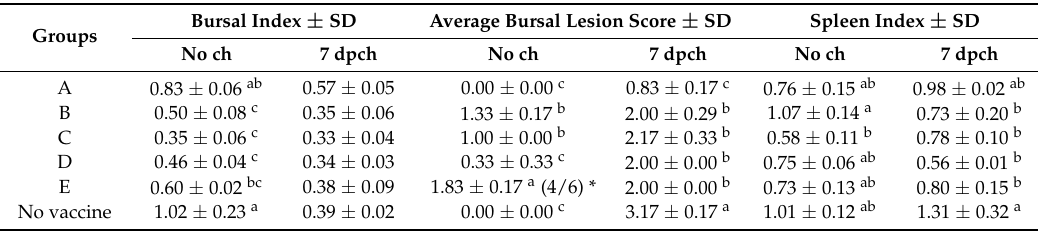
Table 2. Bursal index, Bursal lesion score, and spleen index at 35 days on challenged and non- challenged